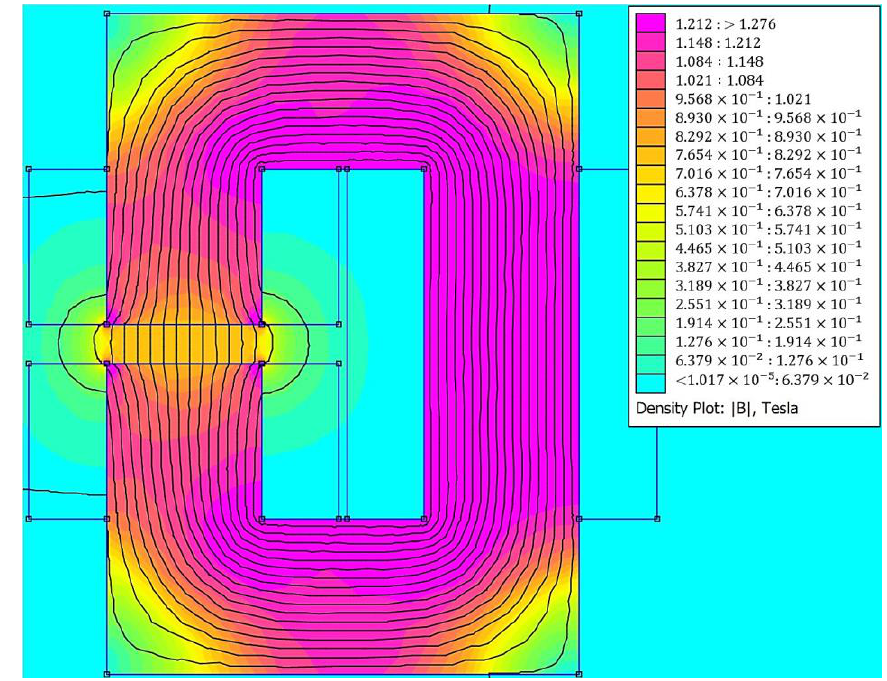
Figure A1. Magnetic flux distribution for the C-shaped electromagnet using FEMM software.